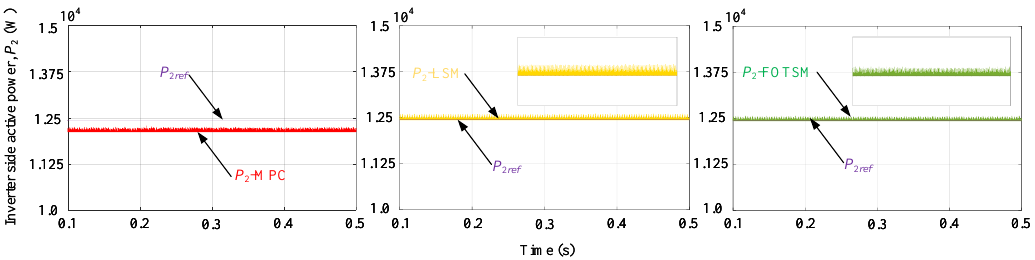
Figure 7. The load grid active power responses under the MPC, the LSM and the